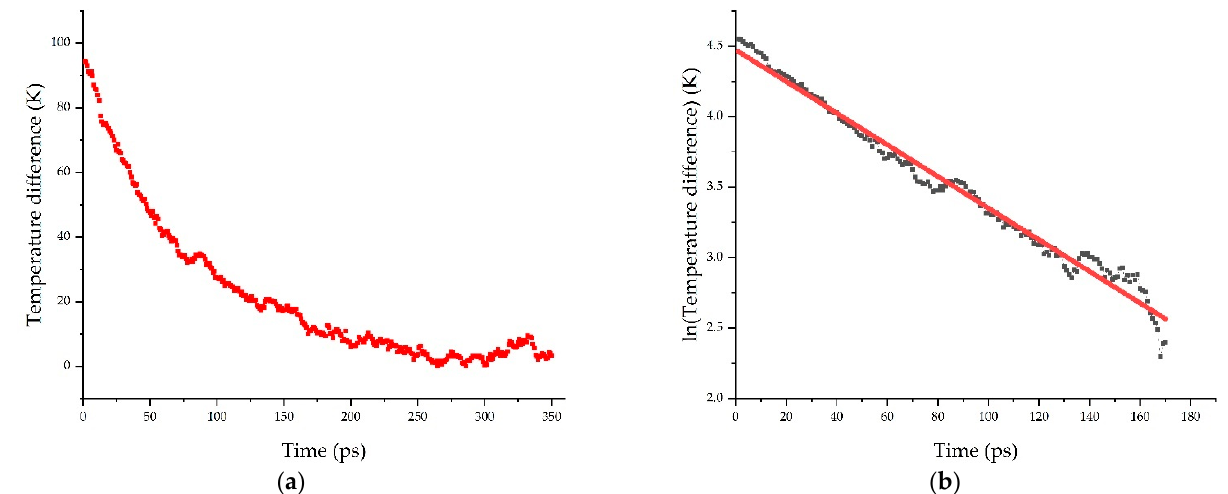
Figure 5. Decay of temperature difference between filler and matrix ( a ), with which the relaxation constant is calculated after linearization ( b ). Curves are obtained from model 2a.